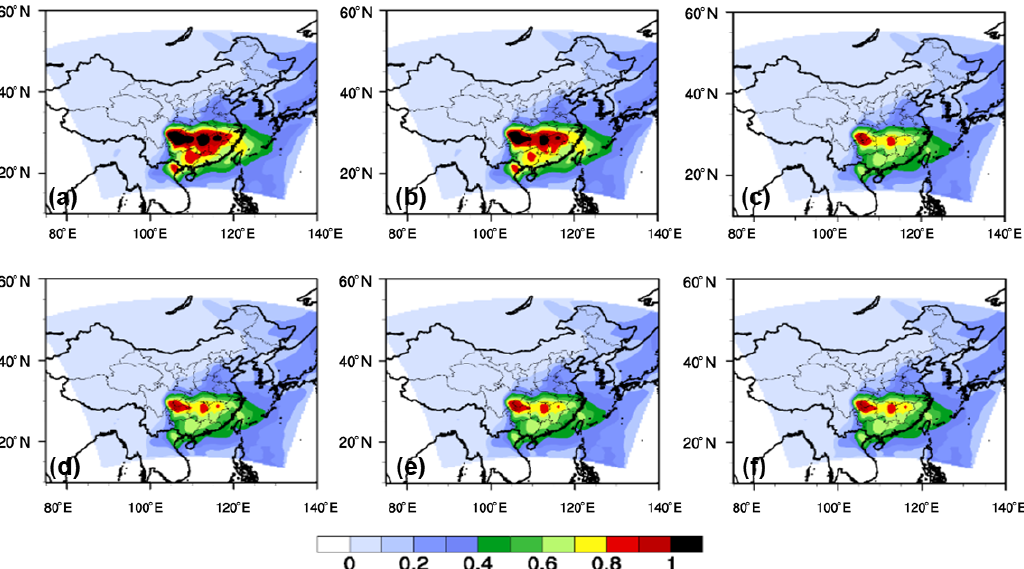
Figure 7. Monthly (January 2010) mean RIEMS-Chem modeled AOD from different simulations: control run (default simulation with internal mixing assumption) (a) , external mixing assumption (b) , internal mixing assumption but without BC (c) , internal mixing assumption but with doubled BC (d) , without dust and sea-salt (e) , and reduced RH (f)